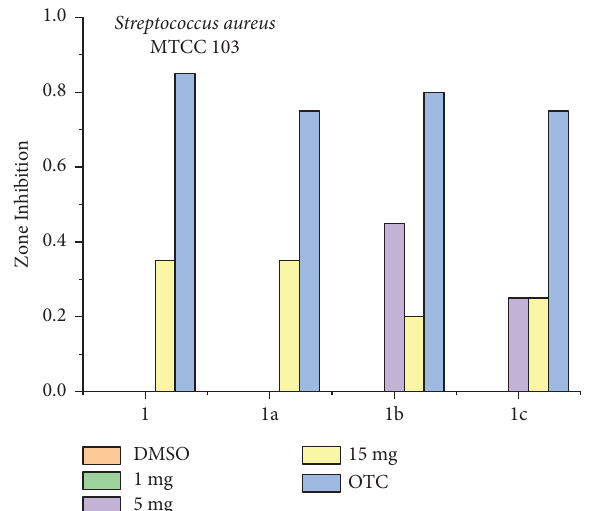
Figure 6: Radius of the zone of inhibition (mm) against K . pneumoniae (MTCC-109) in the range of 1–15mg/mL sample ( 1 , 1a , 1b , and 1c ) with positive control of 50mg/mL